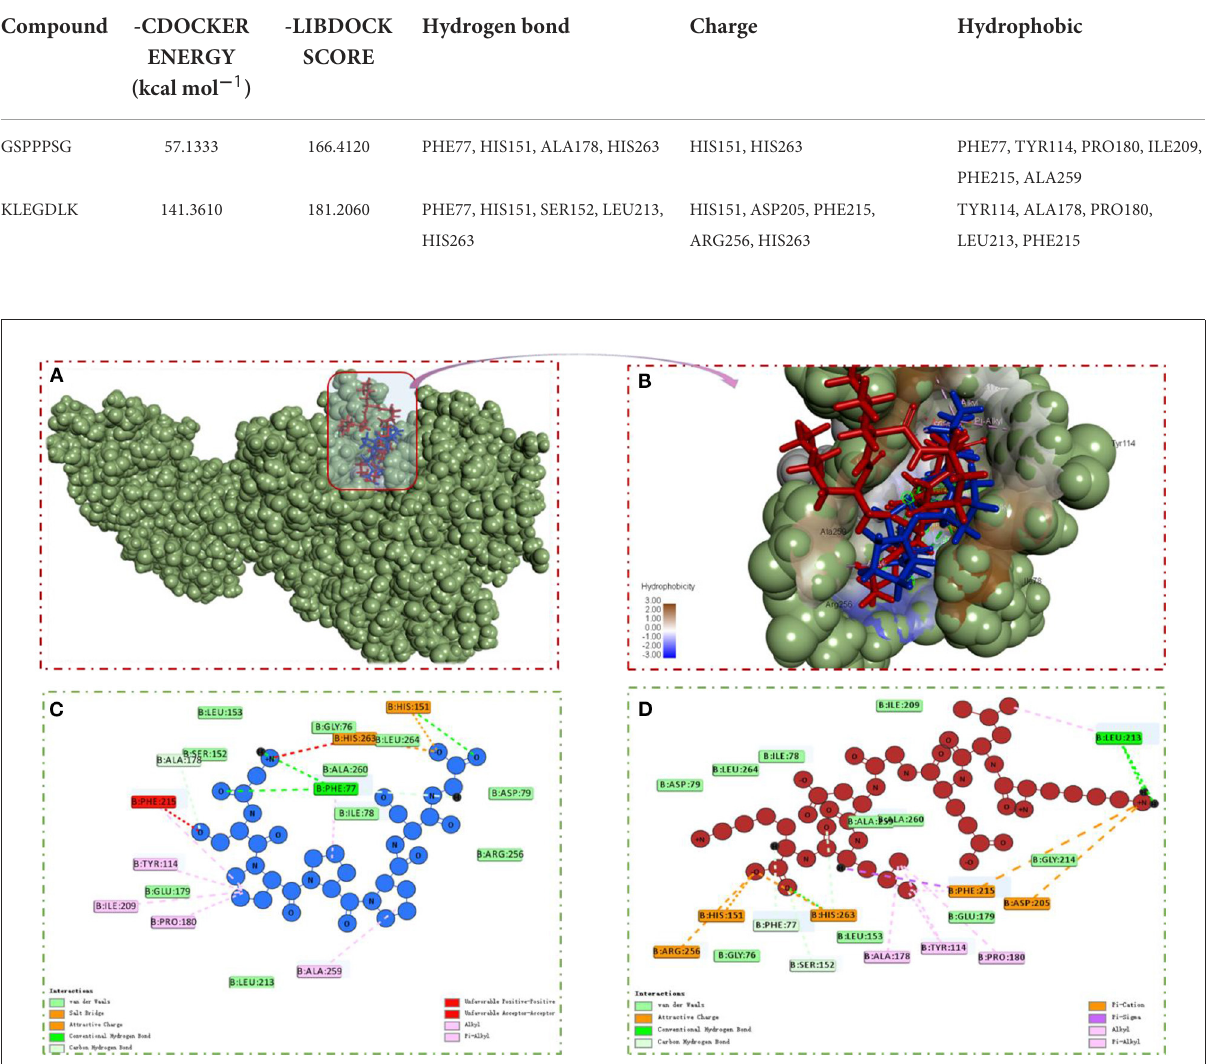
TABLE 2 Interaction summary of GSPPPSG, and KLEGDLK with the active site of the PL.